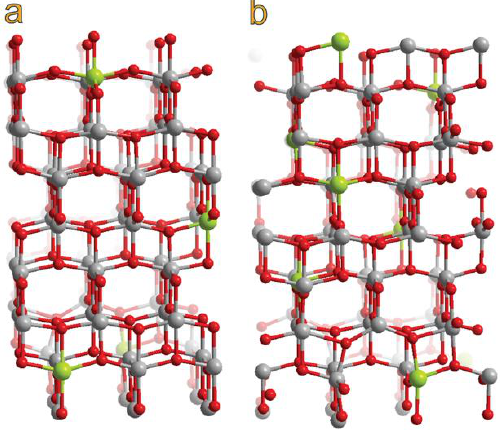
Figure A2. Sc-doped anatase (3 × 3 × 2) supercell models corresponding to 5 wt.% ( a ) and 10 wt.% ( b ) Sc 3+ optimized at the PBE + U level of theory.